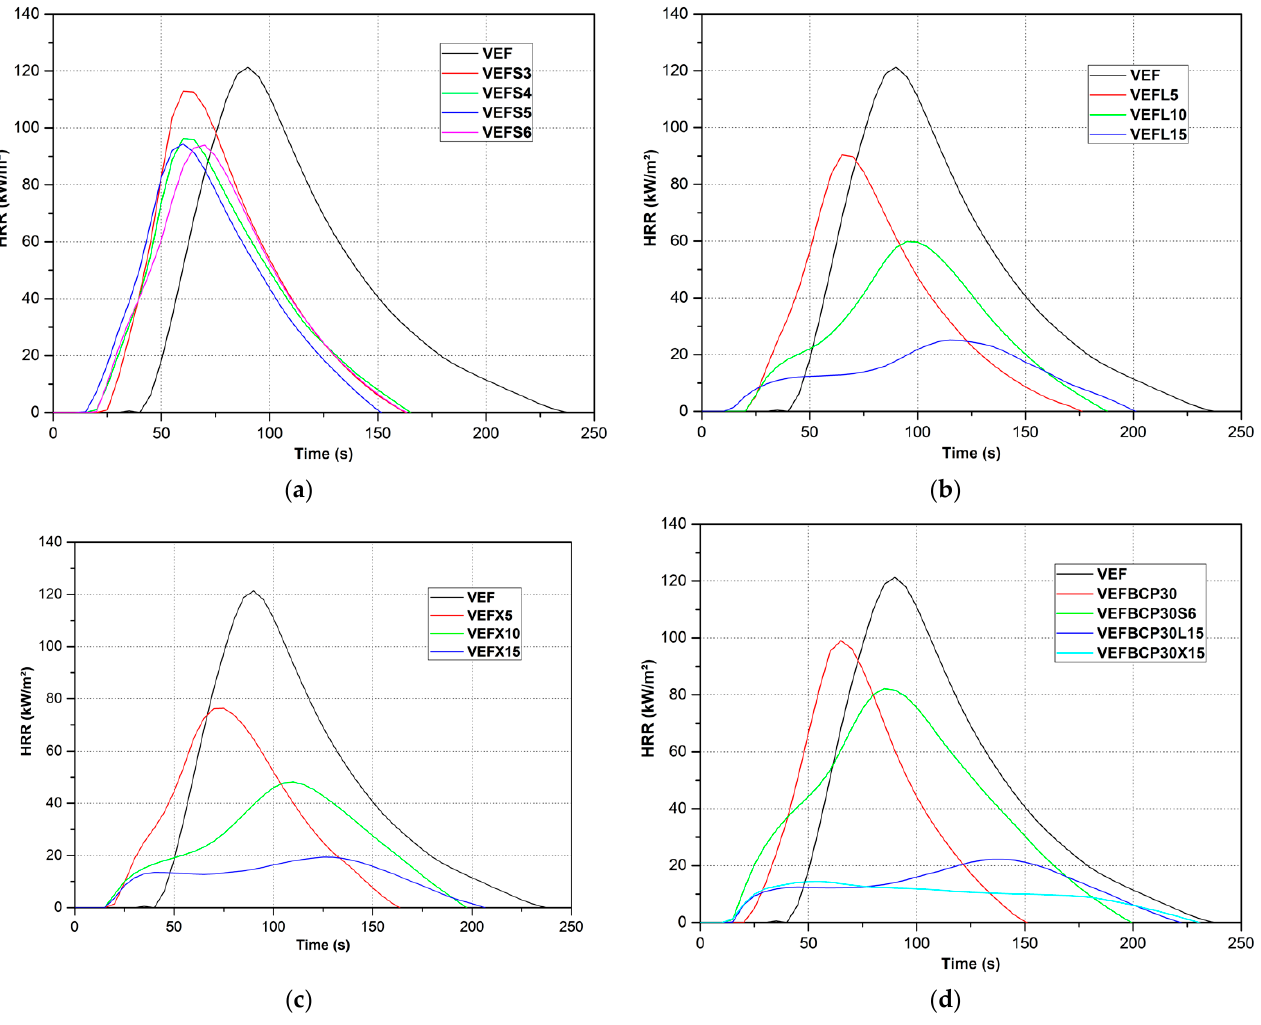
Figure 10. Heat release rate (HRR) curves as a function of time during flammability tests performed in the MLC calorimeter of unmodified polyurethane foam and foam composites containing: ( a ) EG S, ( b ) EG L, ( c ) EG X, ( d ) BCP, and BCP with EG S, EG L, and EG X.